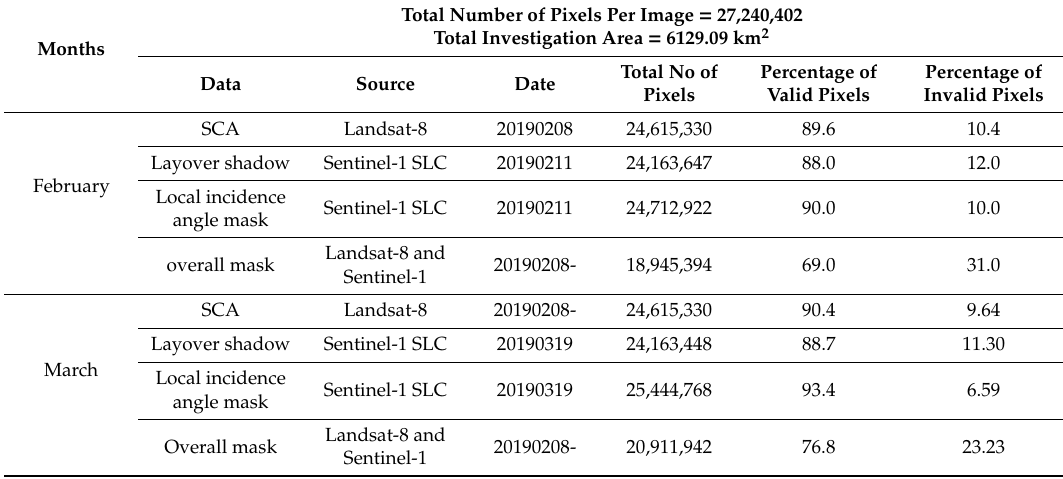
Table 2. The information for study investigation in terms of the number of pixels available for analysis.